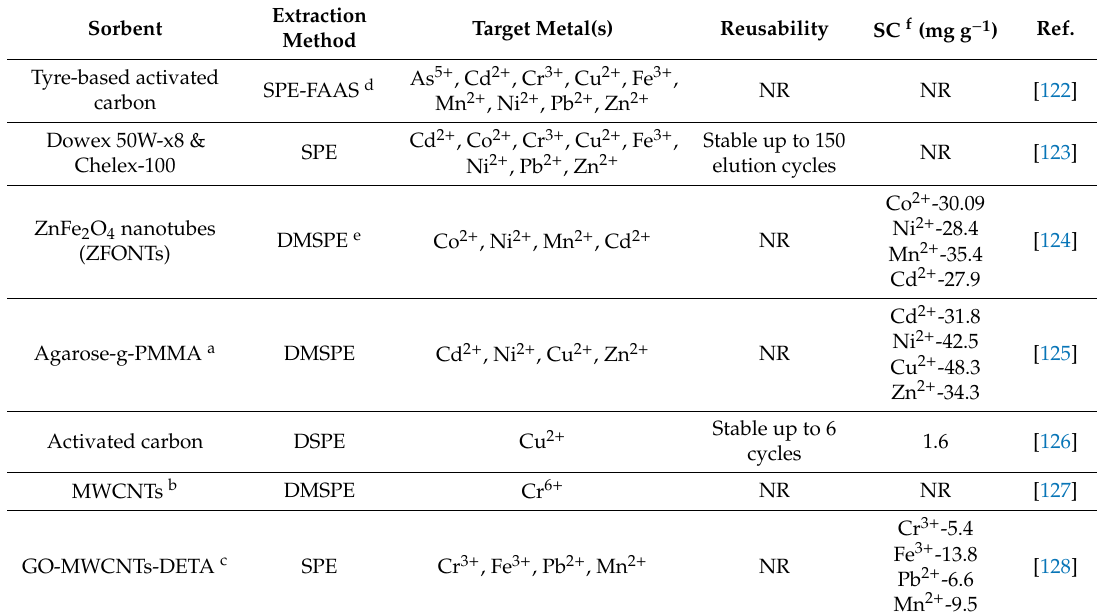
Table 4. Nanomaterial-based solid